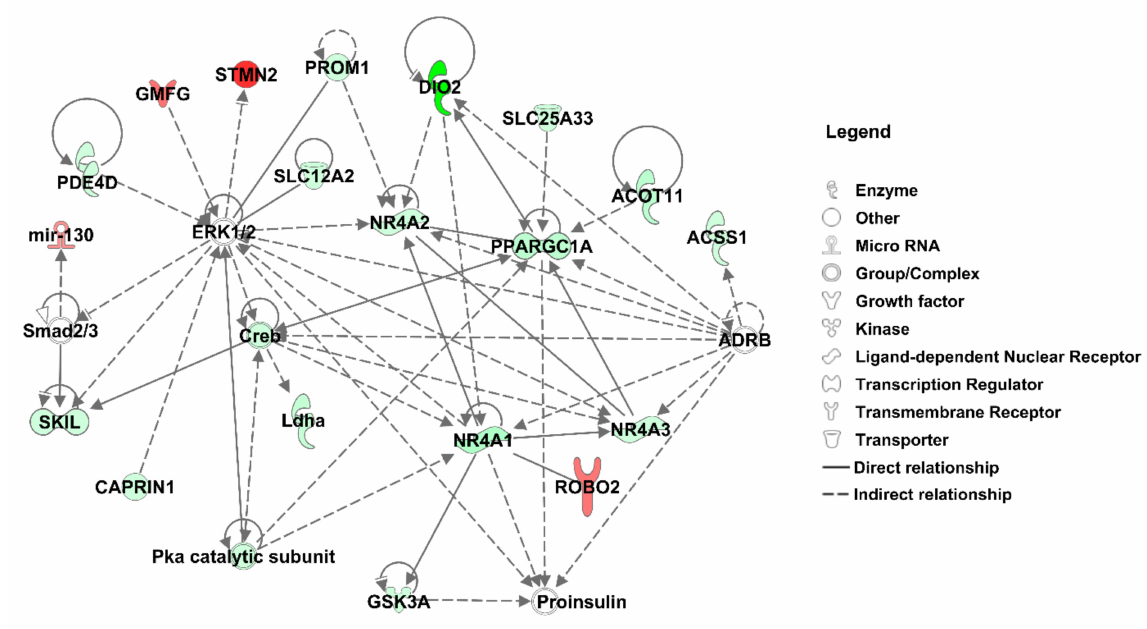
Figure 4. Mechanistic network reaching the highest score for the effect of ellagic acid on the expression profile of brown adipose tissue. The effect on expression of genes significantly differentially expressed between ellagic acid-fed and control rats is shown in shades of green (downregulation by EA) or red (upregulation by EA). Derivation of the network was performed using Ingenuity Pathways Analysis